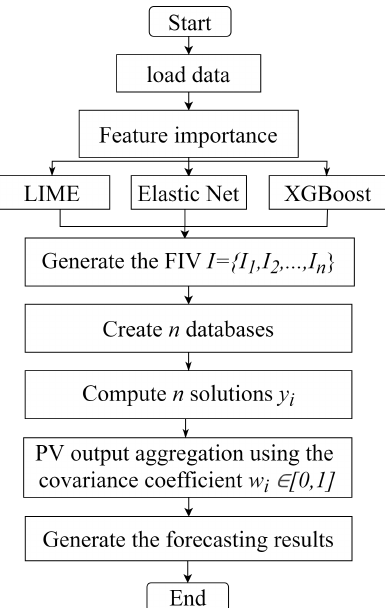
Figure 3. Flow diagram for proposed model